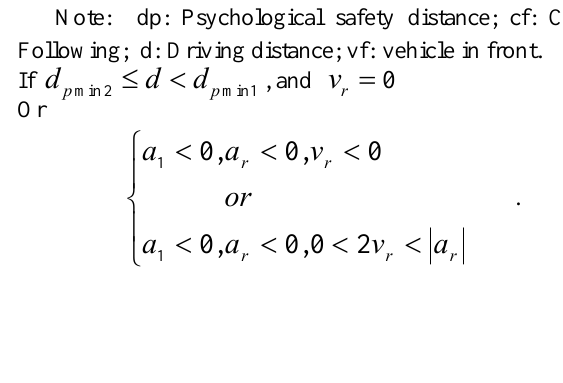
Fig.3. Vehicle driving state diagram